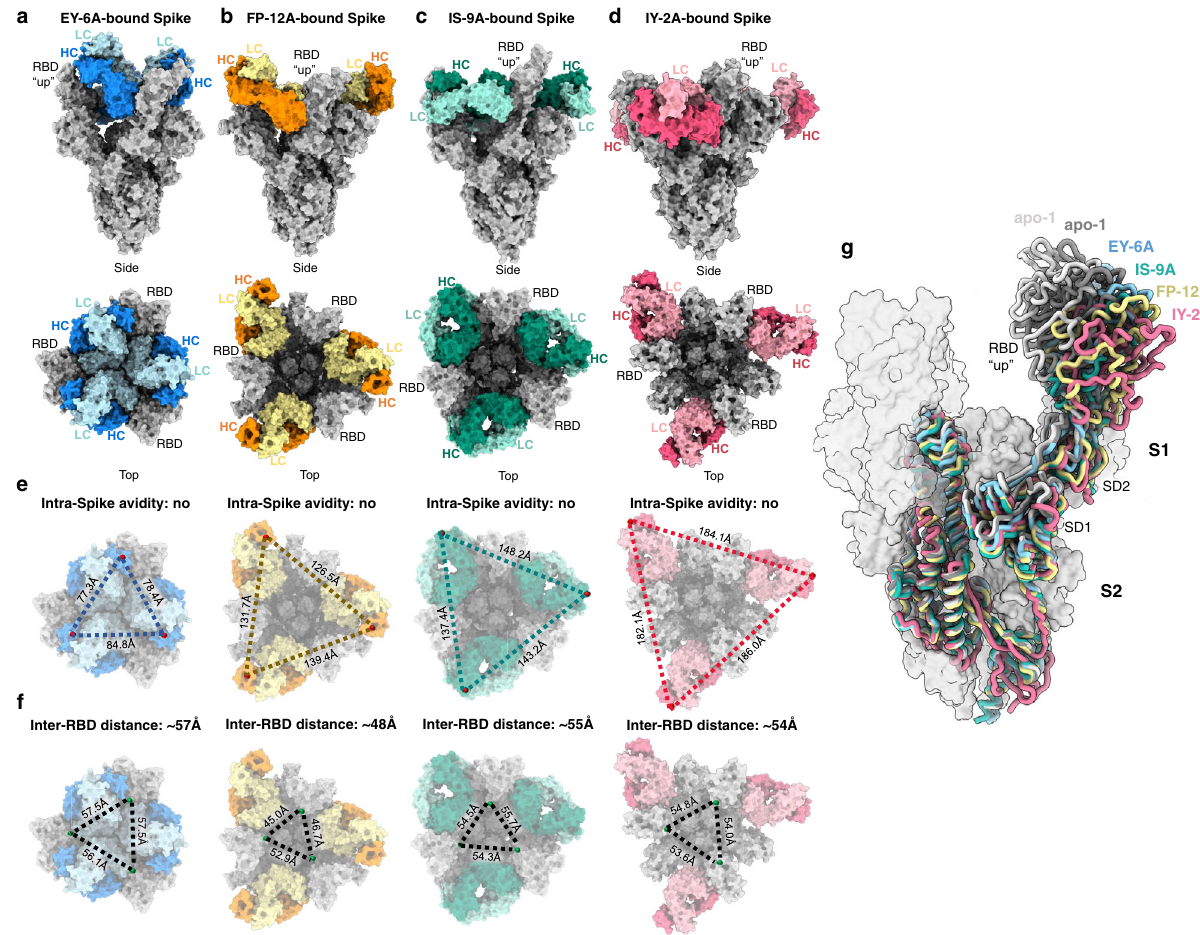
Fig. 5 | Cryo-EM structures of class-4-mAb-bound Spike protein. a – d Surface representation of cryo-EM structures of the Spike-Fab complex for EY-6A 6,14 ( a ), heavyandlightchainsindarkandlightblue,PDBcode6ZDH),FP-12A( b ),inorange and yellow), IS-9A ( c ), in dark and light teal) and IY-2A ( d ), in dark and light red). Spike isshown in gray. All bound RBDs are in the “ up ” conformation. The constant region of Fab is modelled based on EM density at low-threshold rendering. e The potential for intra-spike avidity effects (simultaneous binding of both Fabs of a single IgG to adjacent RBDs on a Spike trimer) was evaluated by measuring the distancebetweentheC-terminal(C224)ofeachbound Fab.Distancesareshownin